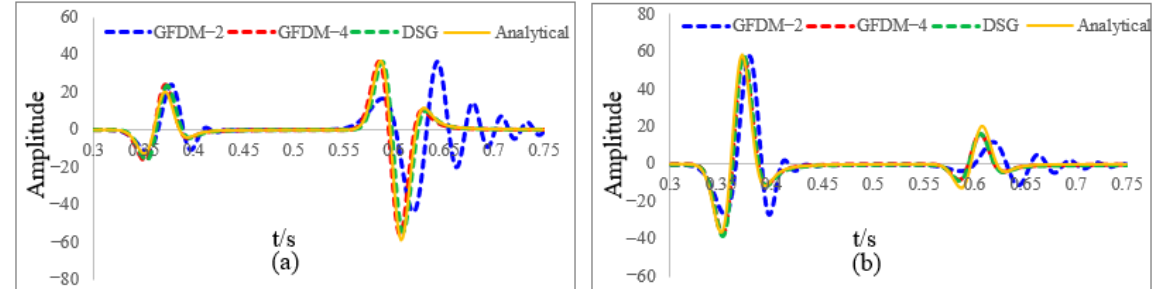
Figure 8. Comparison between the 80th trace of shot records: ( a ) X component; ( b ) Z component.